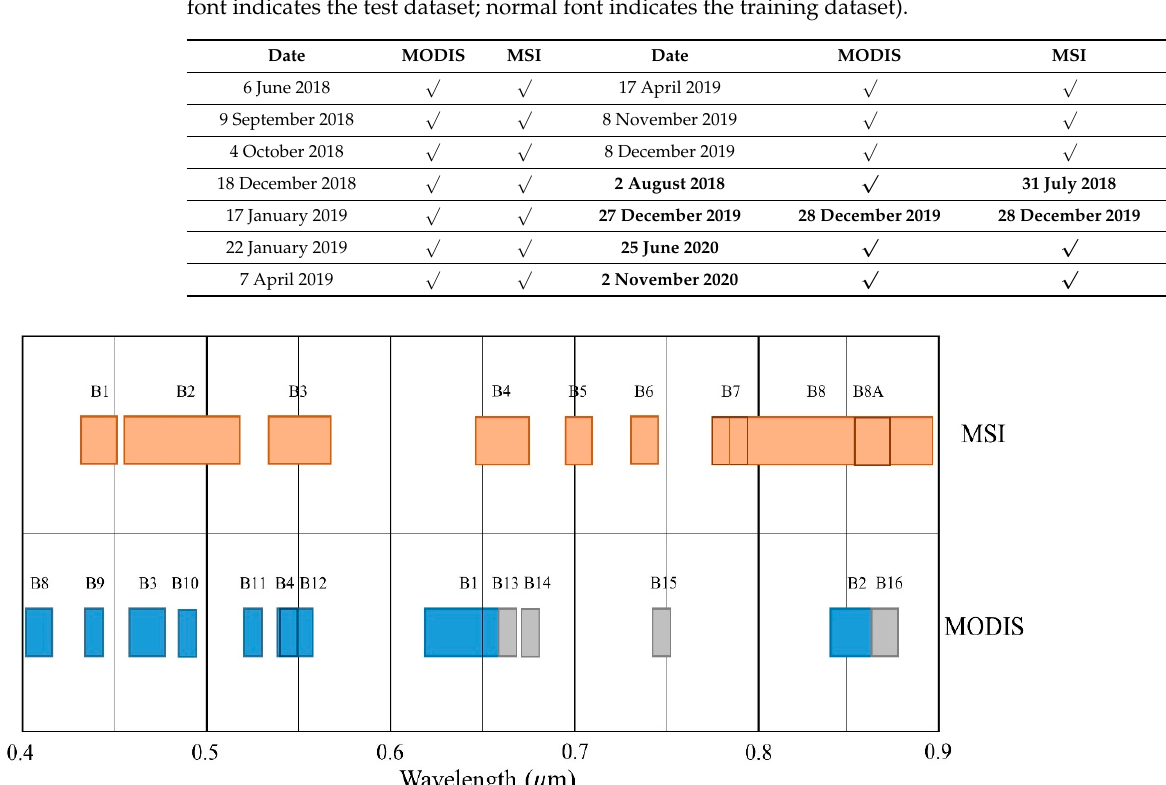
√ ”: available useful images for download; bold